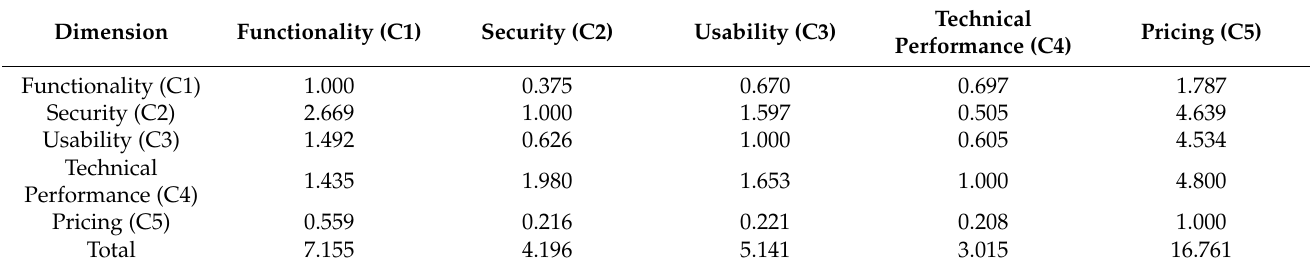
Table 5. The initial comparison matrix of G-AHP.